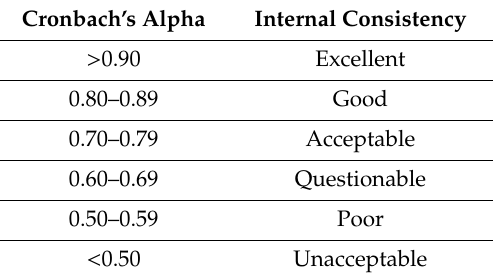
Table 2. Cronbach’s Alpha measures (source: George and Mallory